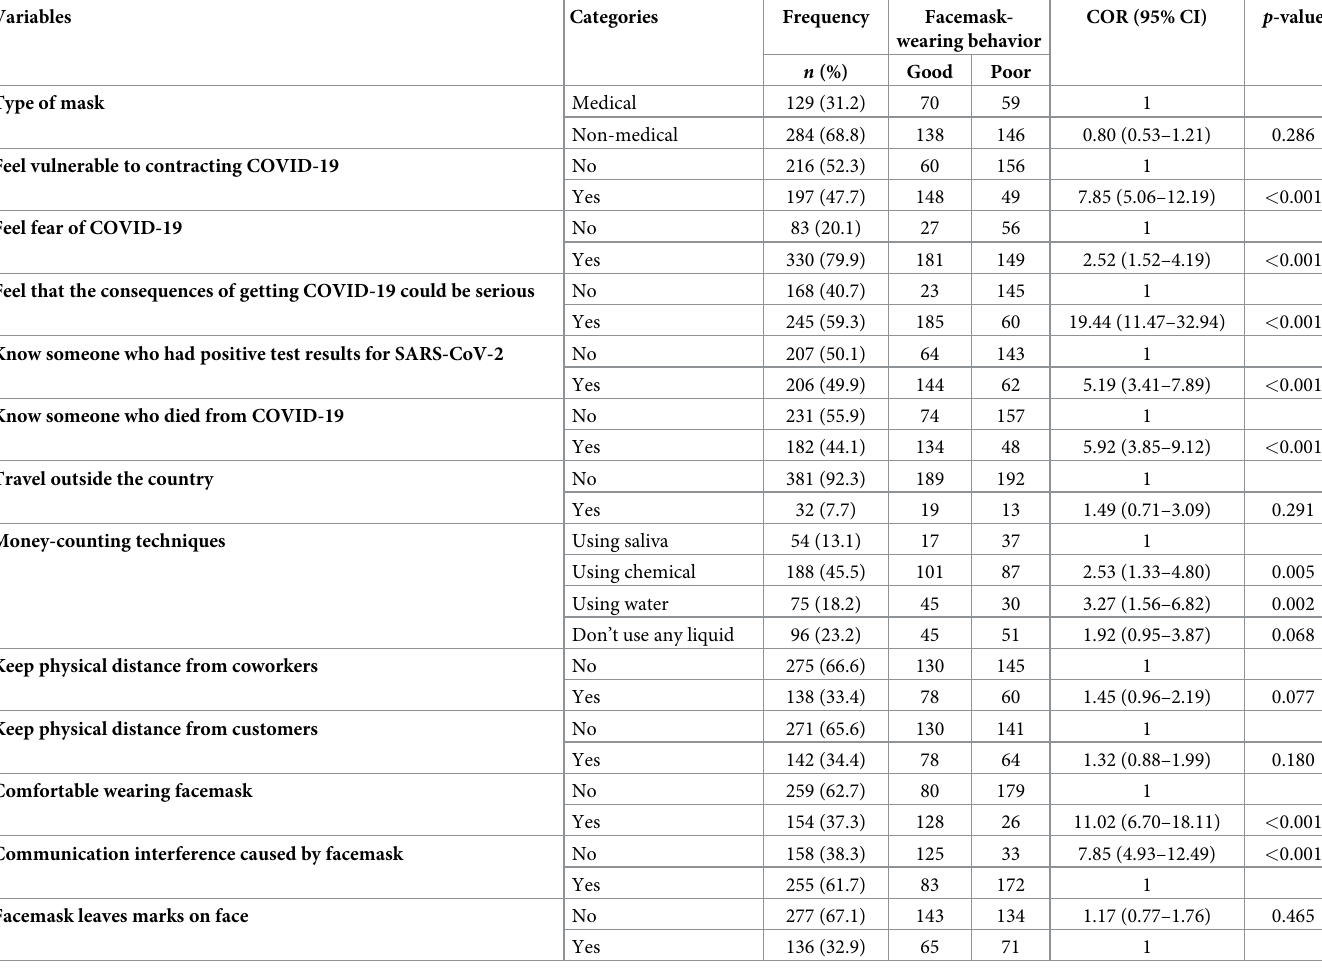
Table 4. Behavioral factors and bivariable analysis with facemask-wearing behaviors among bank workers in Dessie City, Ethiopia, January 2021.